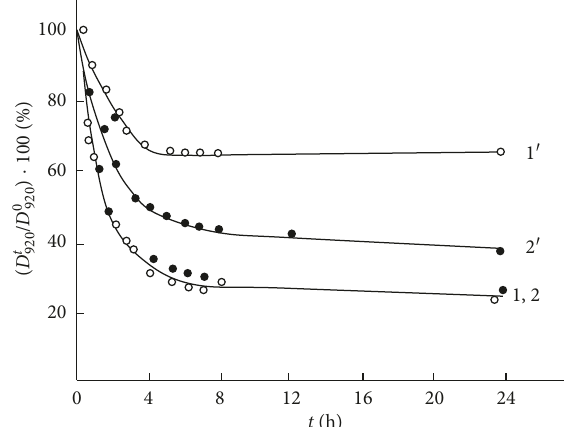
Figure 2: The change in the content of unreacted epoxy groups during the curing of ED-20-DETA (1, 1 ) and ED-20 +DCC/DEG- 1 +DETA (2, 2 spectroscopy (1, 2) and ATR-IR (1 ′ ′